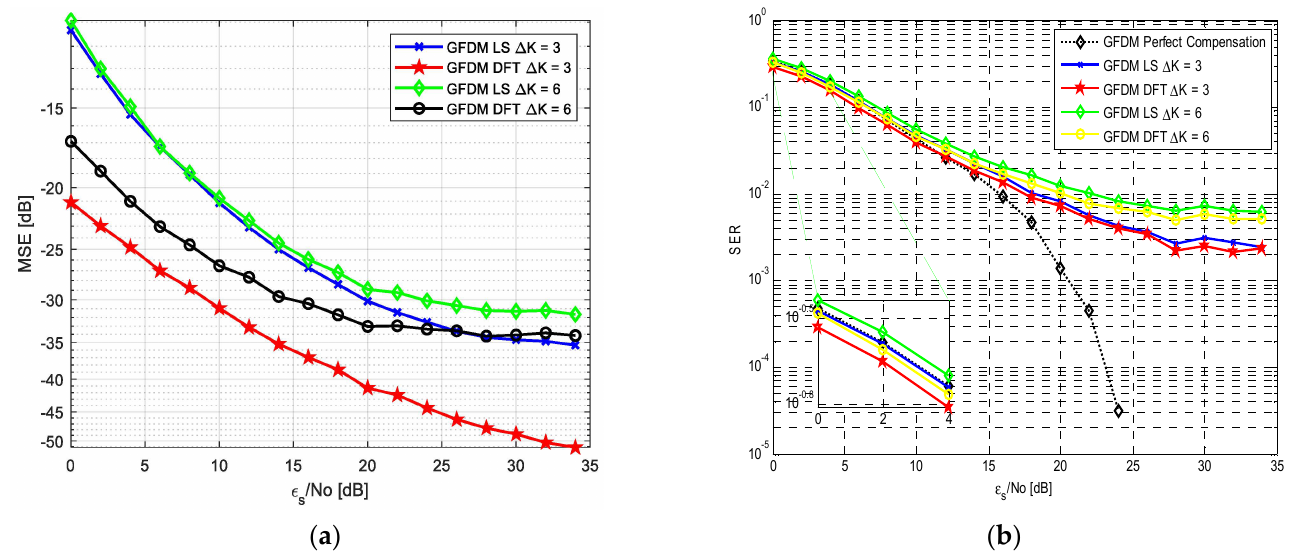
Figure 5. GFDM performance evaluation in term of ( a ). MSE and ( b ). SER with 7% and 14% pilot symbol overhead.